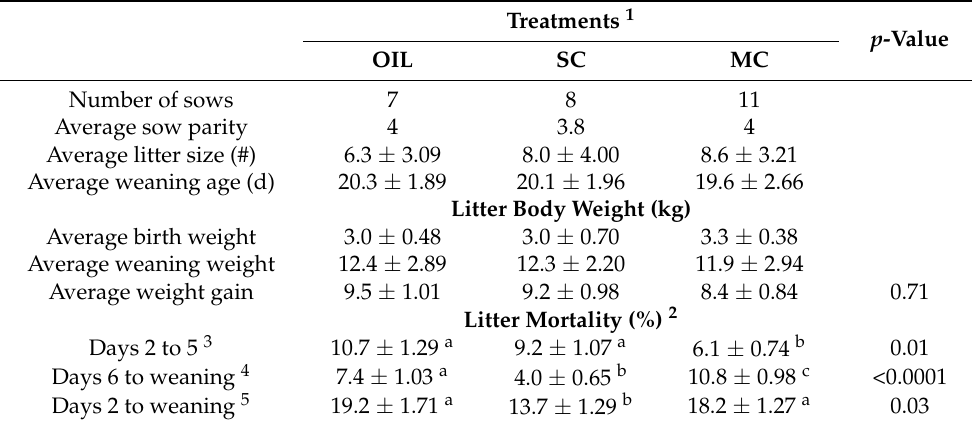
Table 2. Preweaning performance measures of litters provided with environmental enrichment ropes over Days 2 to 5 after farrowing. Results are presented as the LSMeans ± SE where statistical analysis was performed, or as the mean ± SD where results are presented